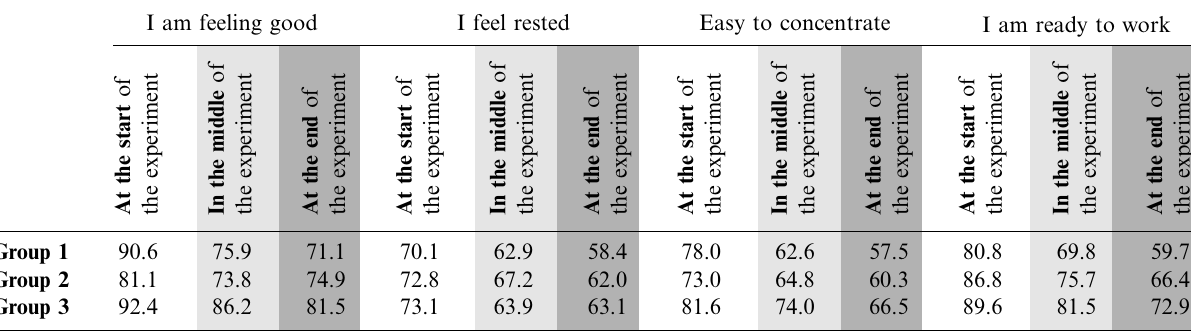
Table 3. Results of the questionnaire survey performed during the experiment (The values in the table are given in %, where 0% means the statement is totally untrue, and 100% means the statement is totally true) I am feeling good I feel rested o